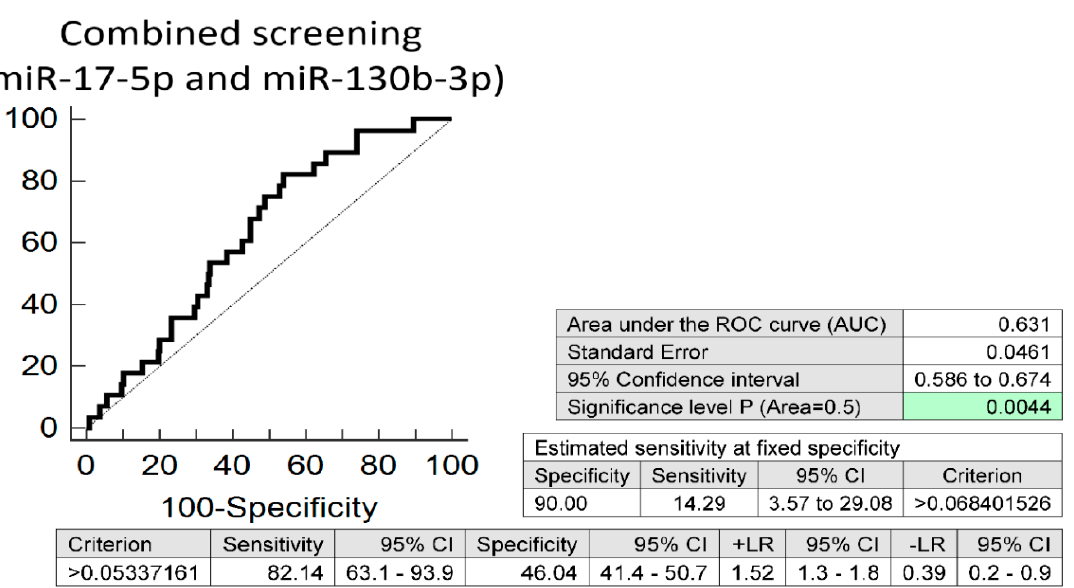
Figure 2. Aberrant microRNA expression profile in mothers with systolic hypertension. Irrespective of the course of previous gestation (normal and complicated pregnancies altogether), screening based on combination of miR-17-5p and miR-130b-3p showed the best performance from various microRNA combinations. At 10.0% FPR 14.29% mothers with systolic hypertension had substantially altered expression profile of miR-17-5p and miR-130b-3p.